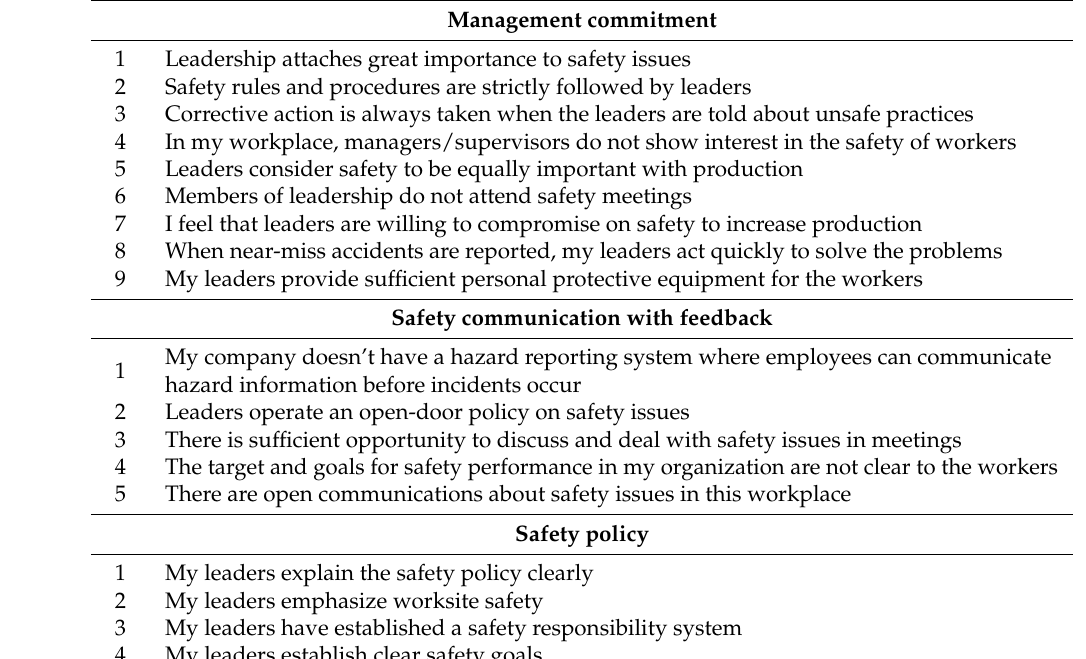
Table A1. Items on the leadership safety behaviours questionnaire.